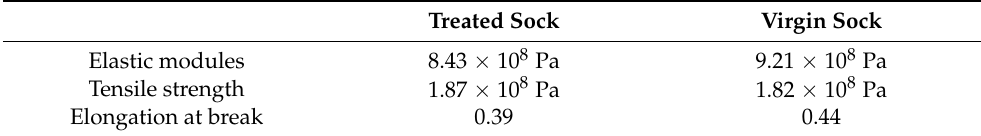
Table 4. Results of the mechanical characterization of treated